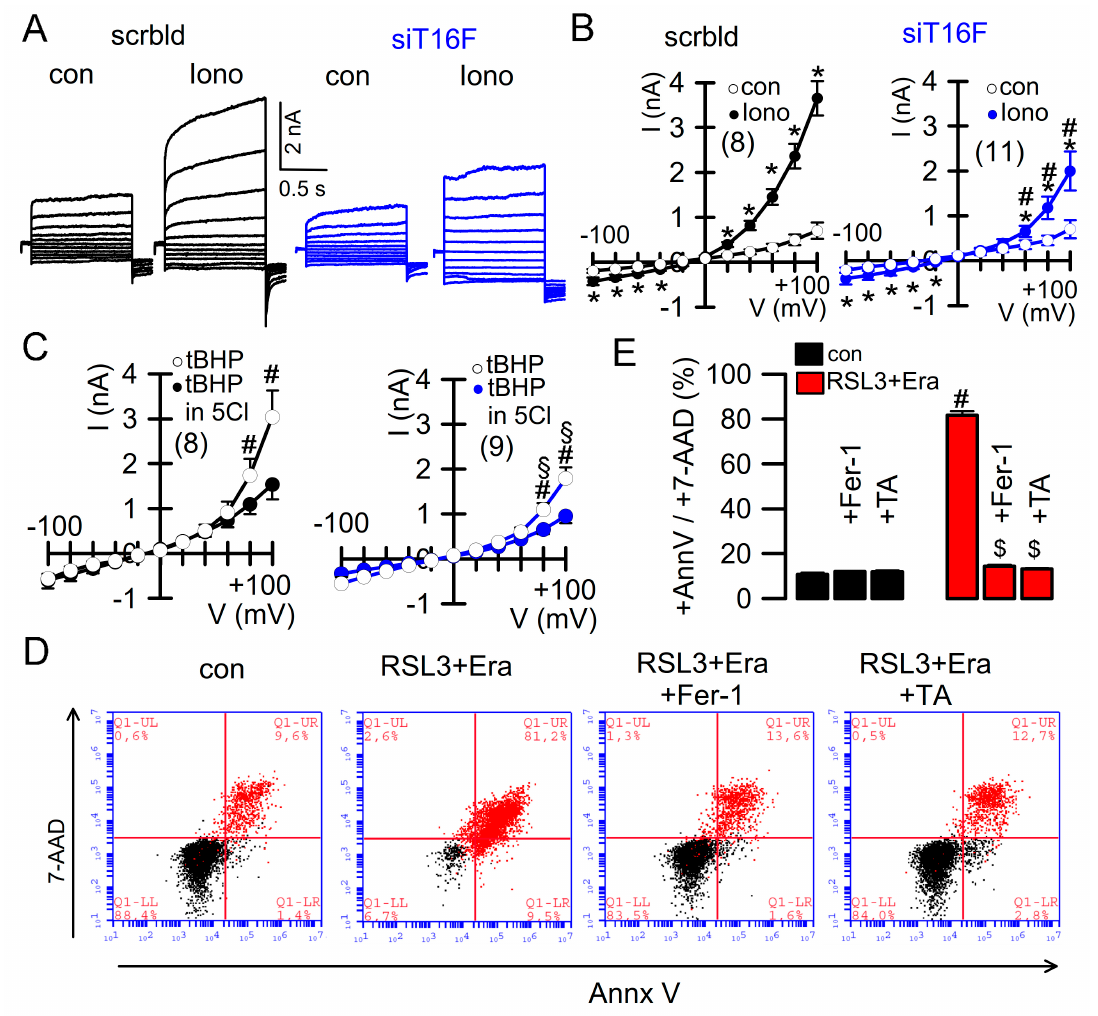
Figure 3. Activation of cell death in in Jurkat T-lymphocytes. ( A , B ) Whole cell patch clamp currents activated by ionomycin (Iono, 1 µM) in Jurkat T lymphocytes, and corresponding current/voltage relationships. ( C ) Activation of whole cell currents by tert -butyl hydroperoxide (tBHP; 50 µM/6 h) and inhibition of currents by 5Cl. ( D , E ) Activation of cell death by RSL3 + erastin and inhibition by Figure 1. (Fer-1, 5 µM) or tannic acid (TA, 10 µM). Mean ± SEM (number of experiments). * significant